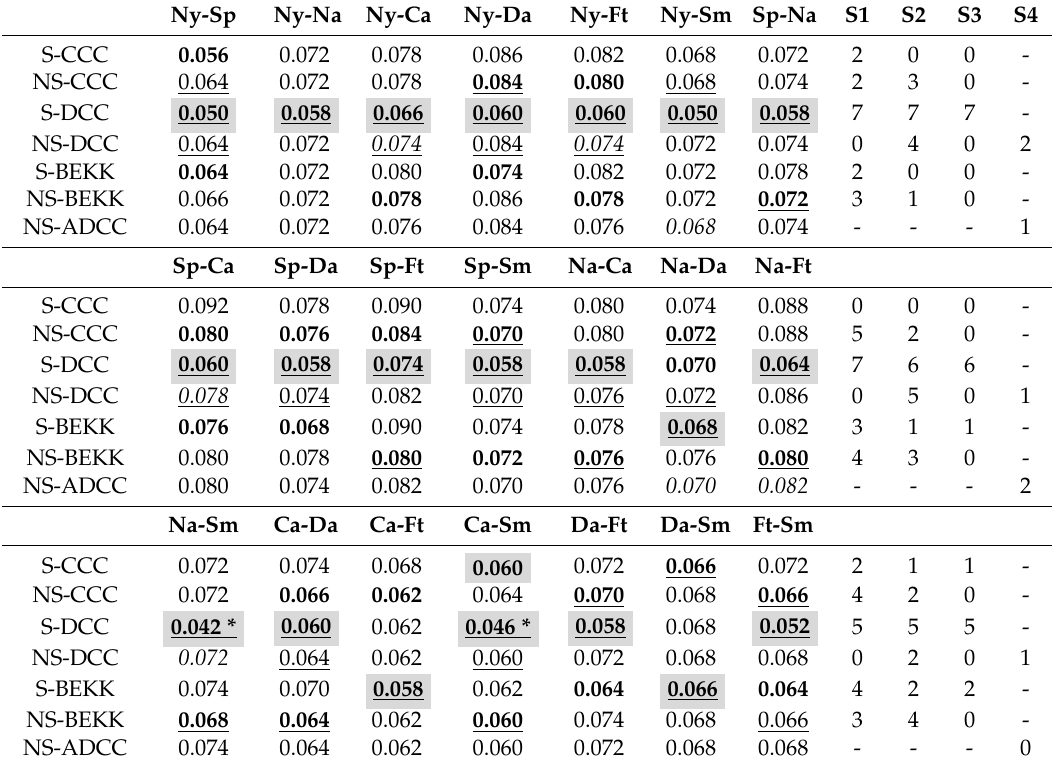
Table 3. The out-of-sample Value-at-risk (VaR) forecasts performance based on the failure rates.